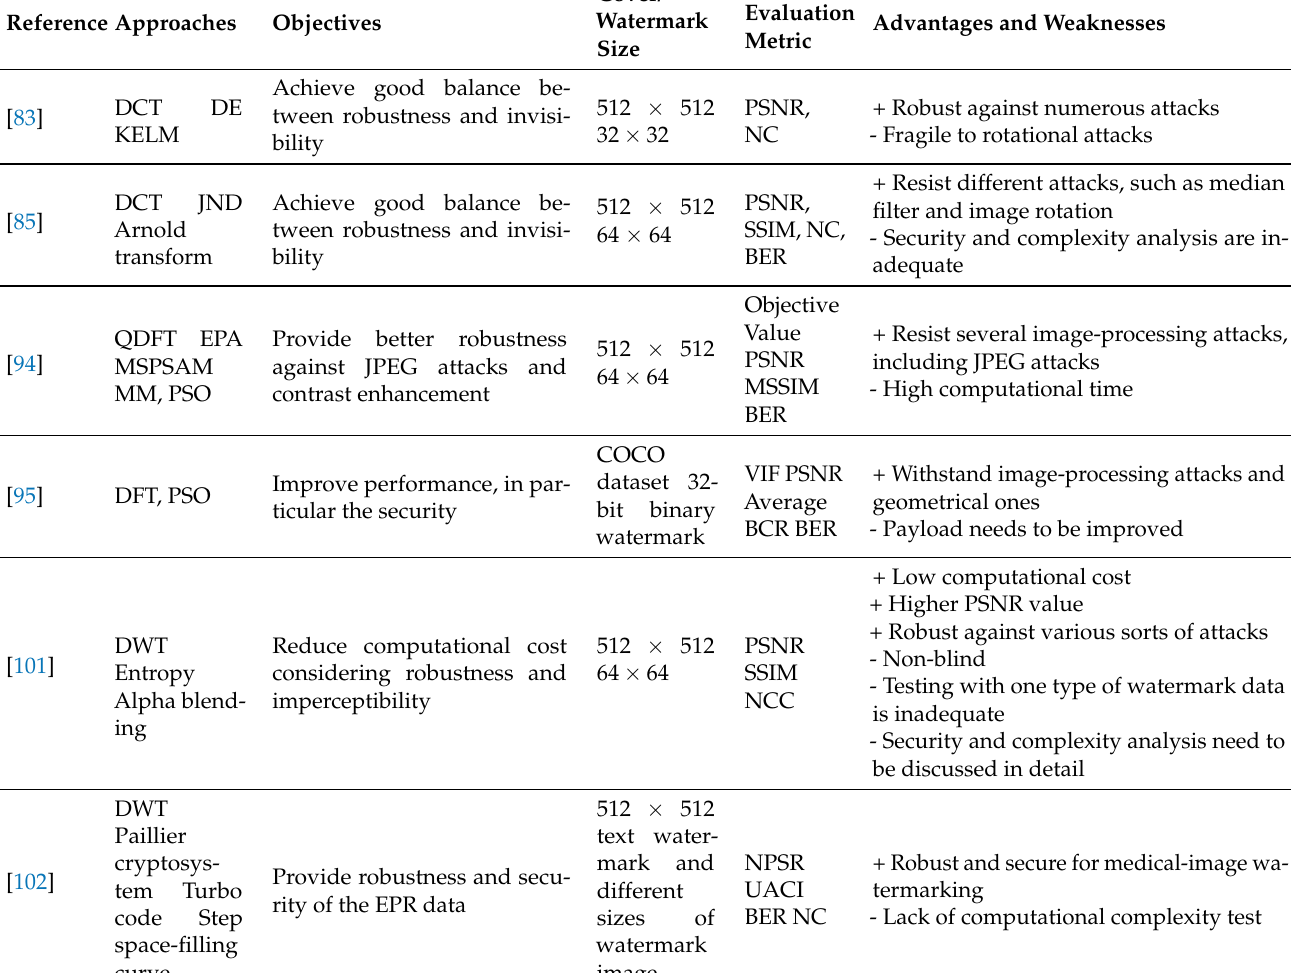
Table 2. Summary of transform domain-based image watermarking